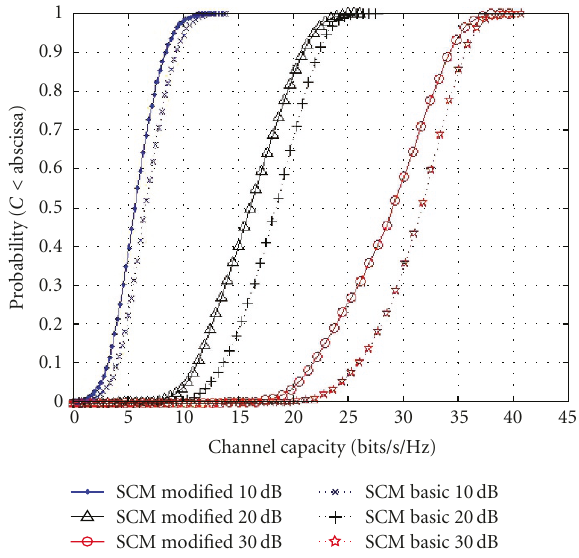
Figure 9: Simulated outage capacity; RMS = 40 degrees.